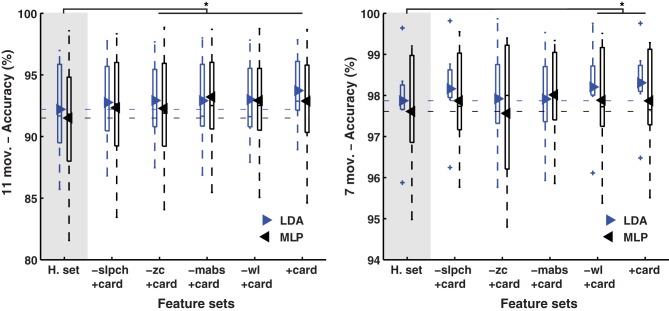
MPR accuracy using sets of EMG features. Accuracy of myoelectric pattern recognition (MPR) of 11 movements (left inset), and a subset of the first seven movements (right inset), using two classifiers (LDA and MLP) in 20 subjects (IM data). The substitution of each feature in the Hudgins set (H. set) by cardinality showed improved accuracy. The dynamic part of the contraction was included during signal processing (cTp = 0.7). The marker “*” represents the statistical significance at p < 0.05.